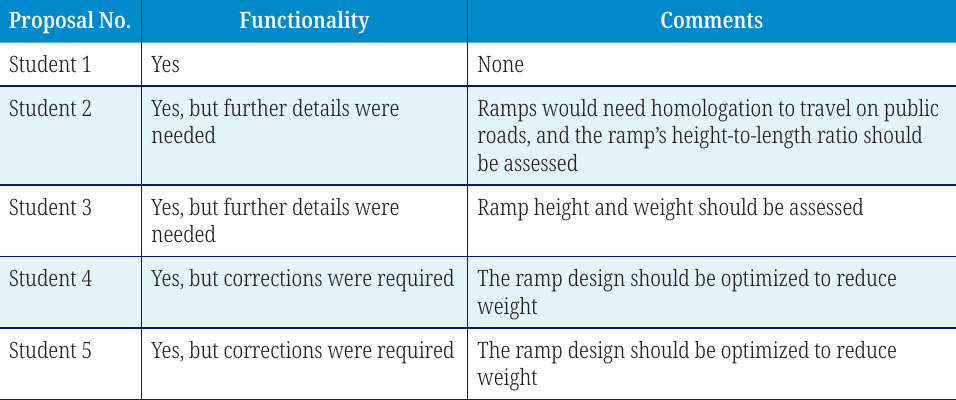
Table 2. Evaluation of the functionality of the students’ proposals